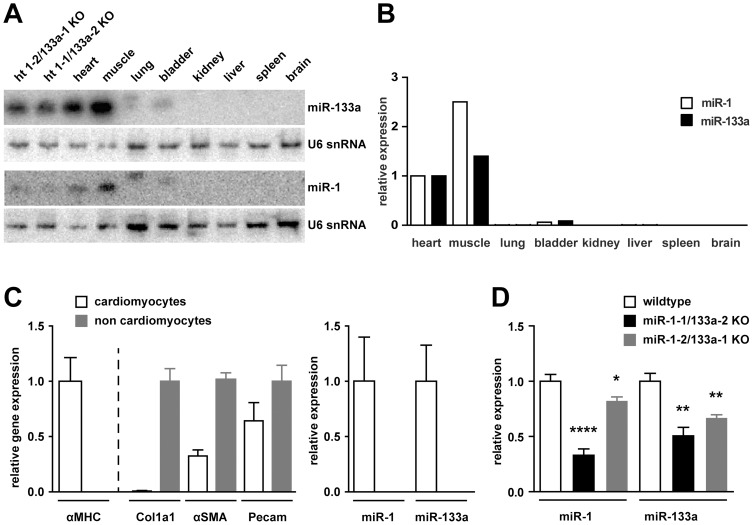
Expression of miR-1/133a in WT and mutant animals.Northern blot (A) as well as quantitative RT-PCR (B) detected the miRNAs miR-1 and miR-133a in total RNA isolated from heart (ht), skeletal muscle (m. tibialis anterior) and bladder. qRT-PCR analysis of isolated cardiomyocytes and non-cardiomyocytes (C). The identity of the fractions was confirmed by αMHC, collagen1a1, α-smooth muscle actin and Pecam/CD133 expression, respectively. Whereas the cardiomyocyte fraction contained some endothelial cells and possibly also smooth muscle cells, the non-cardiomyocyte fraction did not contain considerable amounts of cardiomyocytes. miRNA expression analysis demonstrates that expression of miR-1 and miR-133a is confined to cardiomyocytes (C). Deletion of single miR-1/133a clusters led to a reduced abundance of miR-1 or miR-133a in the heart detected by northern blot (A) or qRT-PCR (D).